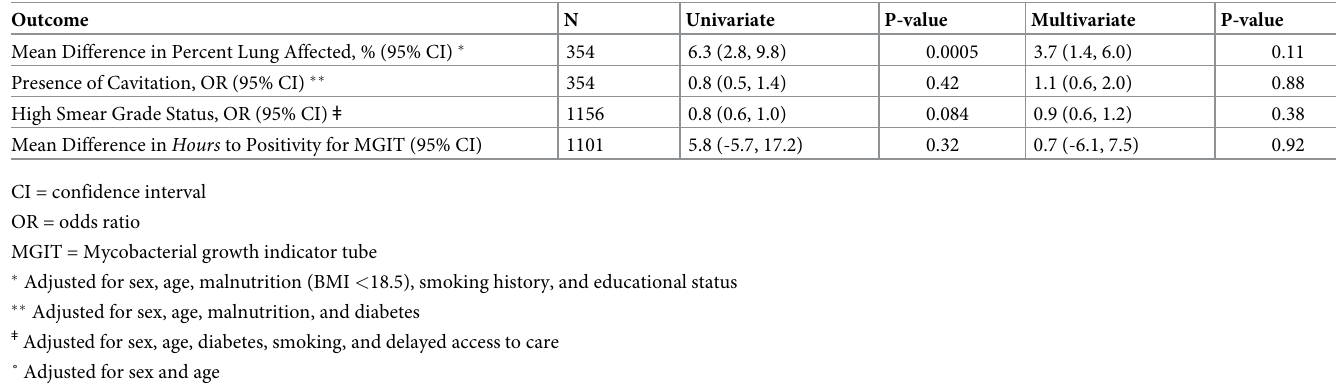
Table 3. Univariable & multivariable linear regression analyses on relationship between being at risk for alcohol use disorder (AUD) and various outcomes, refer- ence group is non-drinkers. Outcome